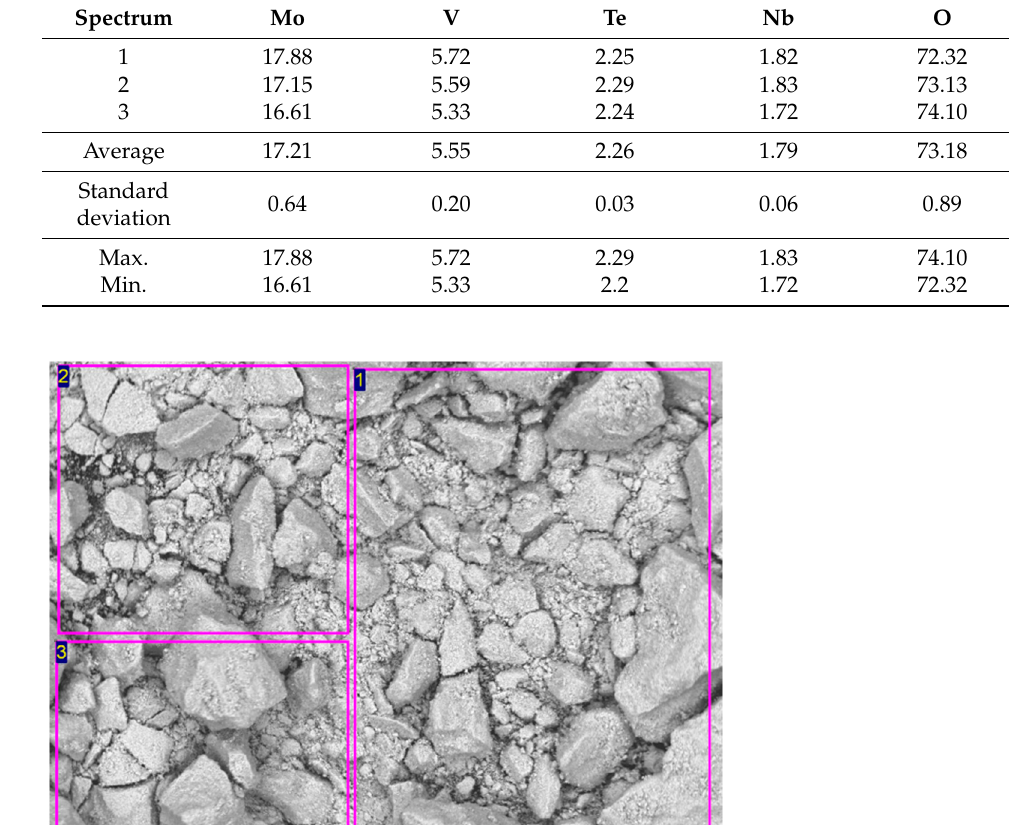
Table 1. The elemental composition of the catalysts obtained by the EDX method (at. %).